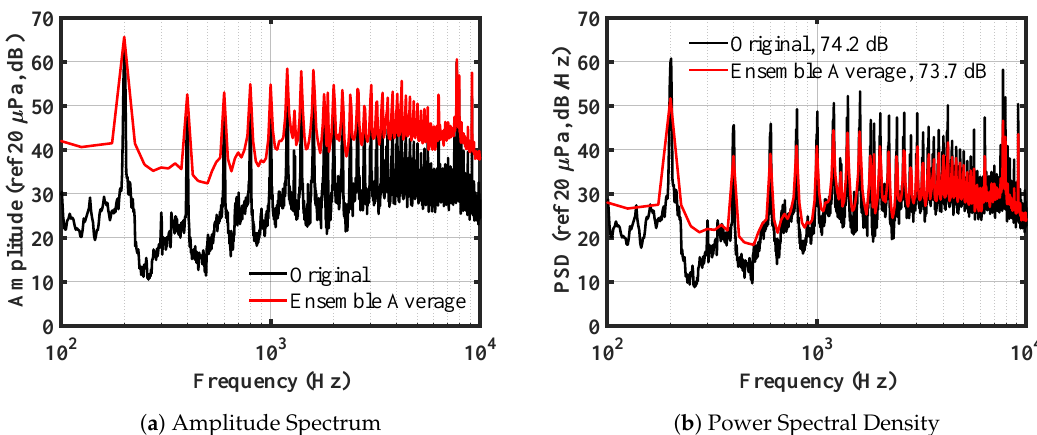
Figure 5. The acoustic spectra of a dual rotor case at an above-plane mic measured in the experiments.